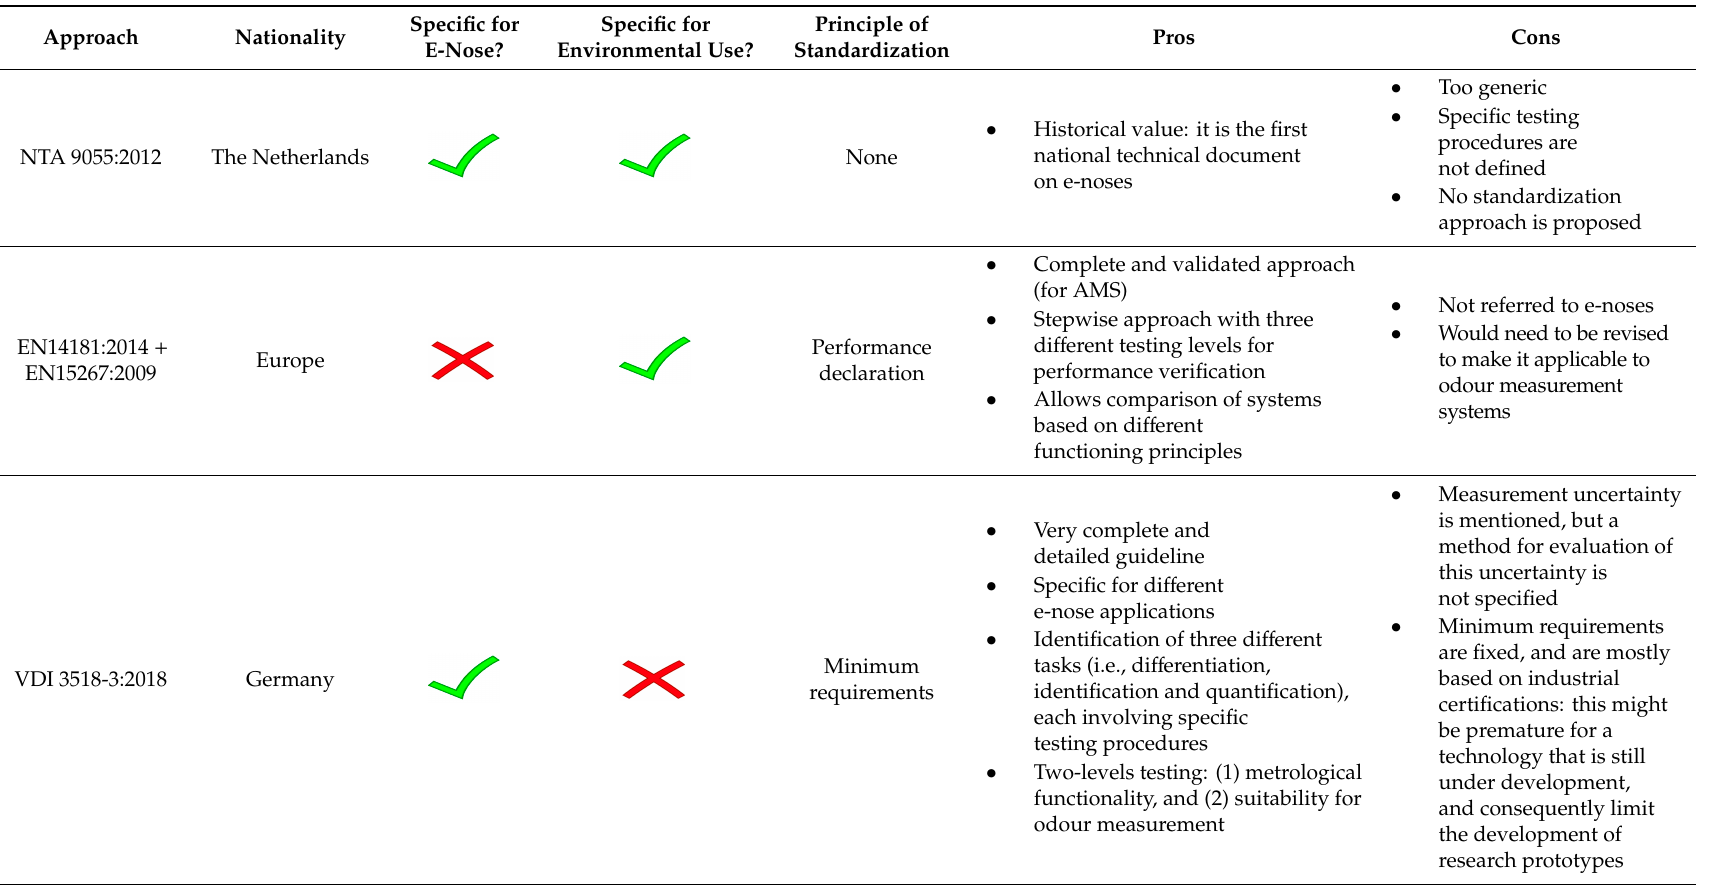
Table 1. Schematization of the existing approaches that can be applied for e-nose qualification and standardization in environmental odour monitoring applications. Approach